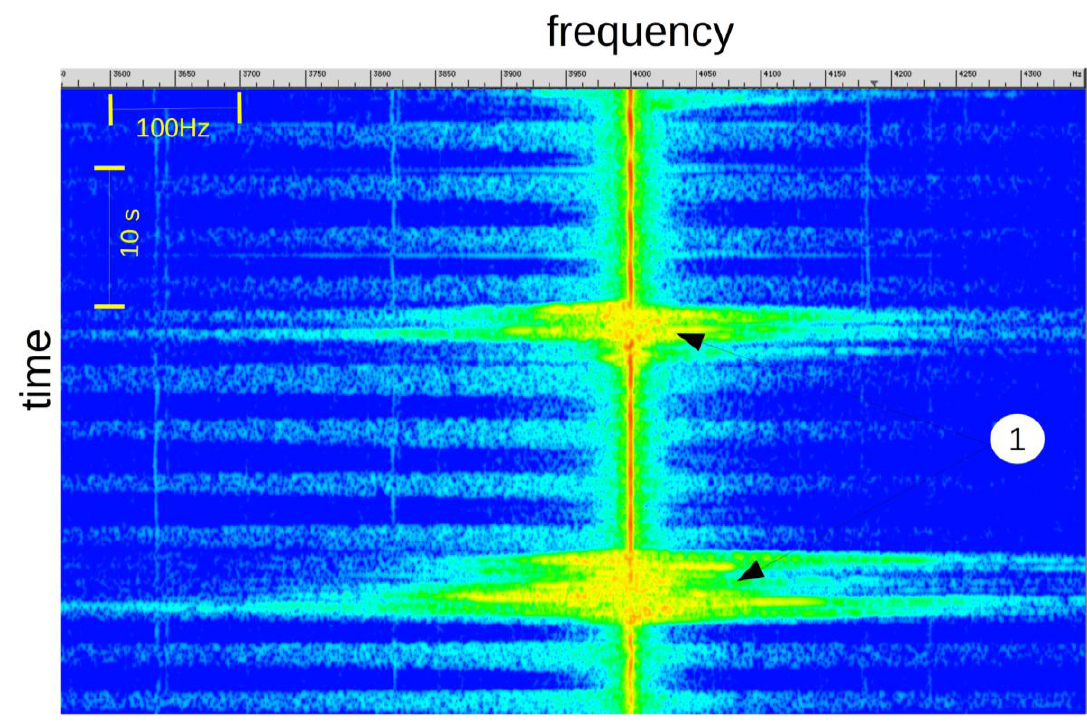
Figure 8. Signal visualization during large and rapid subject